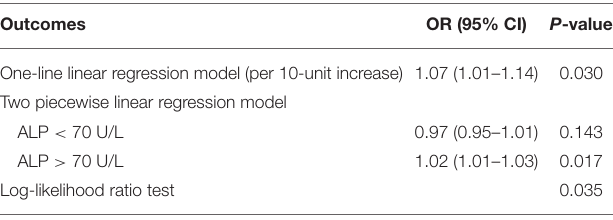
TABLE 4 | Threshold effect analysis of ALP level and 3-month all-cause mortality. Outcomes